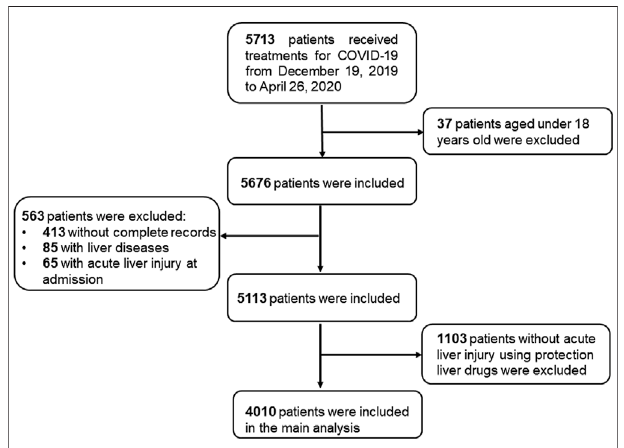
FIGURE 1 | The fl owchart showing the strategy of participant